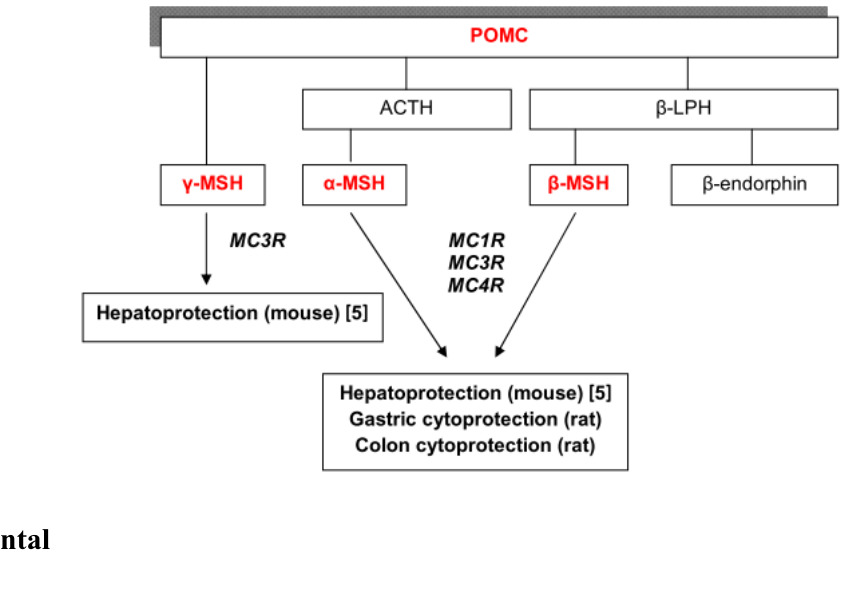
Figure 6. Melanocortin peptides and related receptors involved in the gastrointestinal